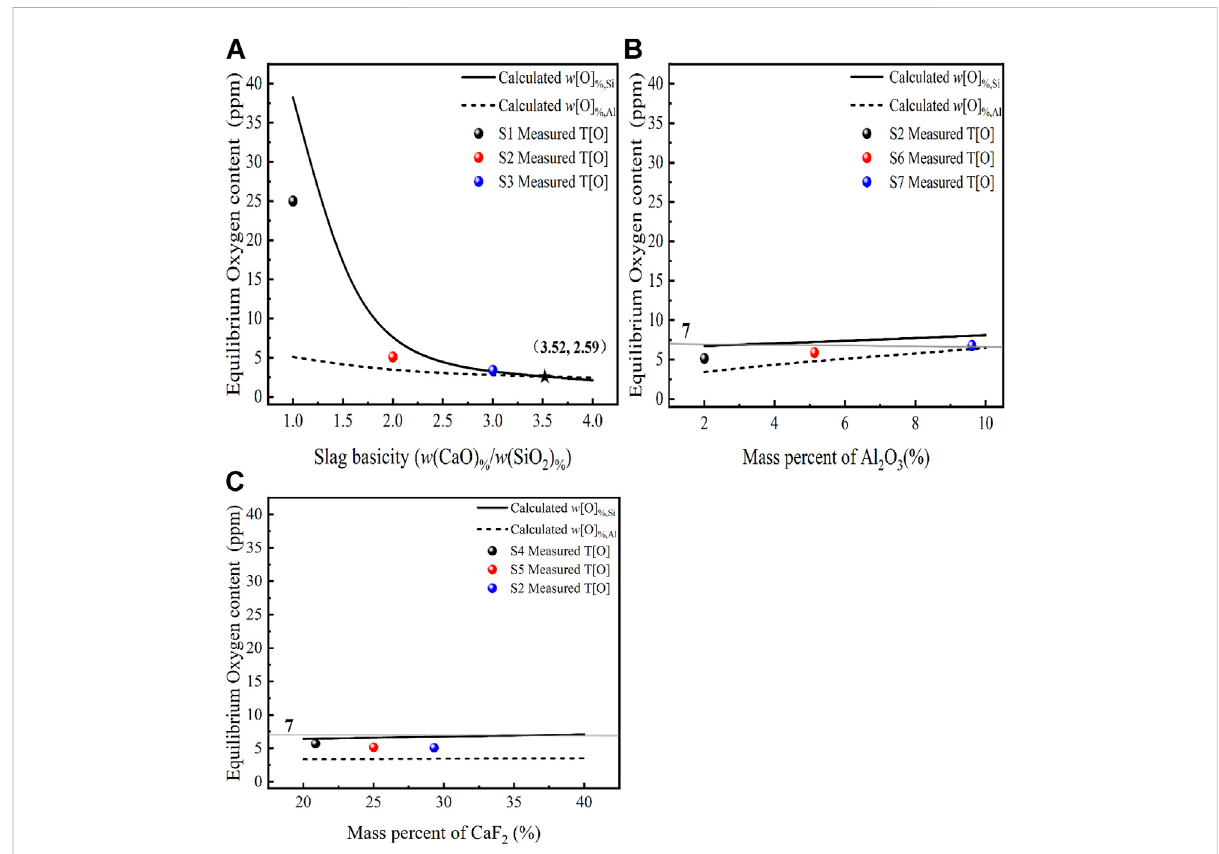
FIGURE 6 Effect of different slag compositions at 1,873 K (A) CaO, (B) Al 2 O 3 , (C) CaF 2 on the oxygen content in steel [model predictions (lines), experimental data (dots) and T[O] = 7 ppm (gray